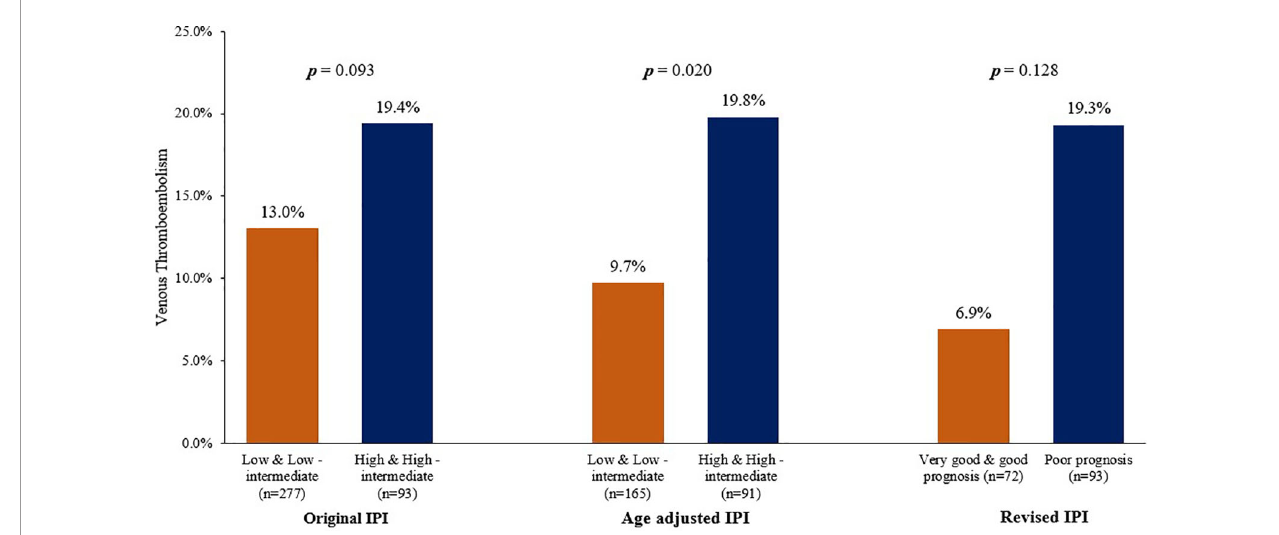
FIGURE 1 | Venous Thromboembolic Event rates according to different IPI